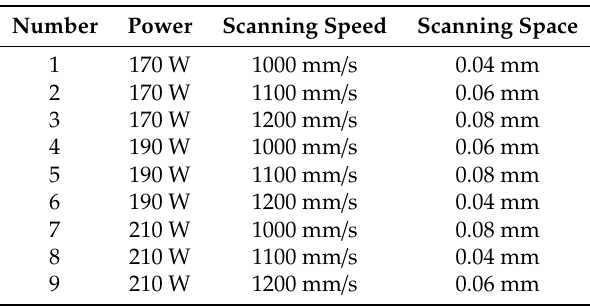
Table 1. L9(3 3 ) orthogonal test